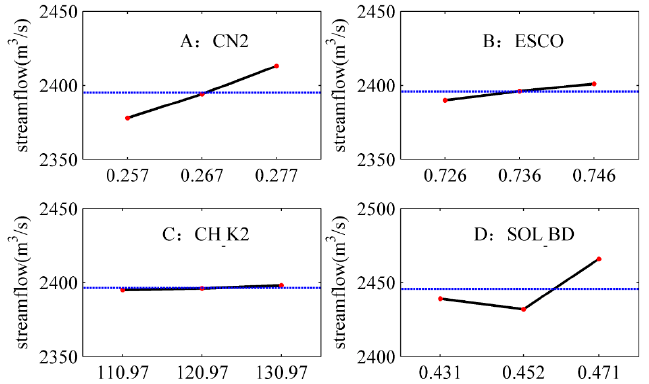
Figure 10. Individual effects of parameters in the flood period.